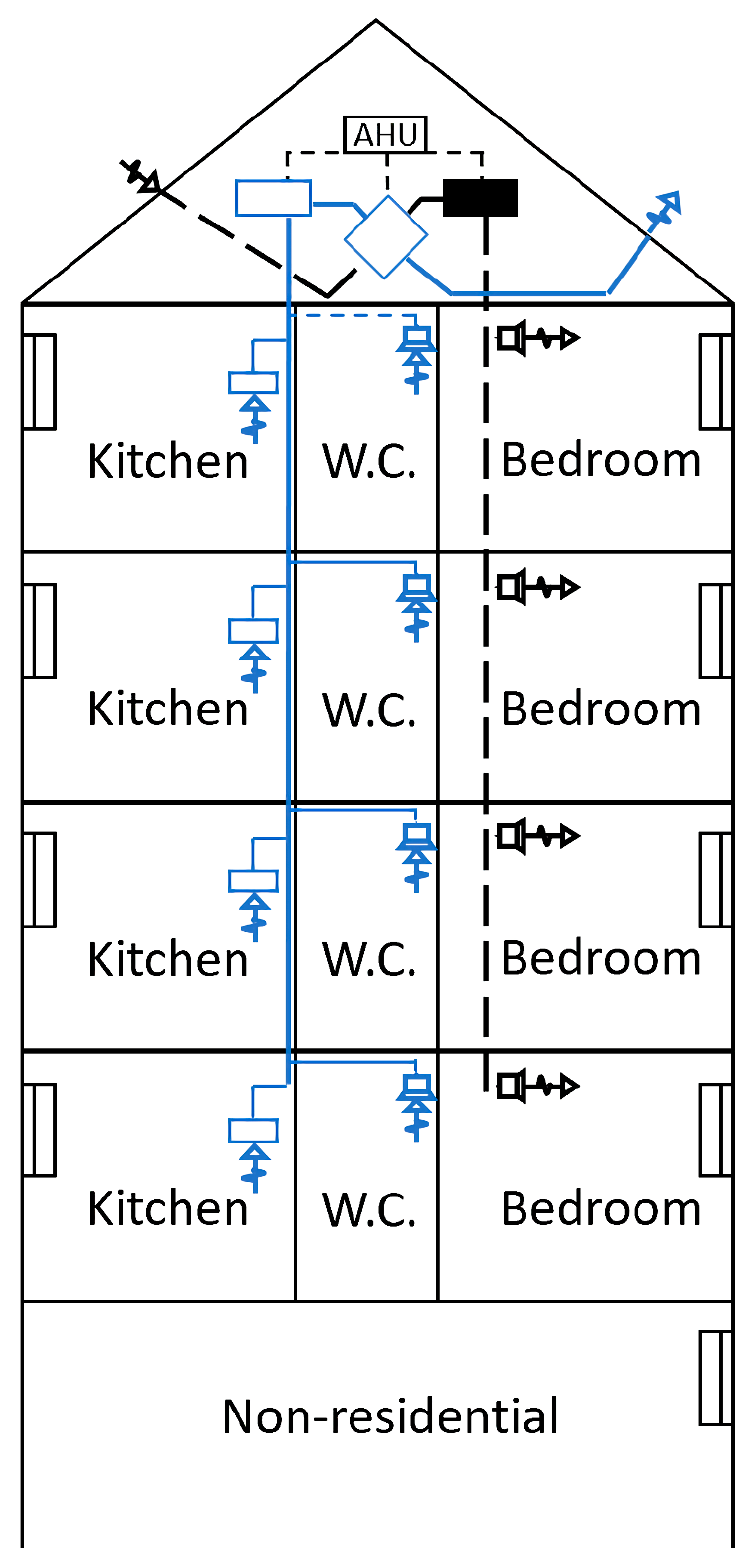
Figure 1. Scheme of the ventilation system in the case building. AHU: Air Handling Unit.